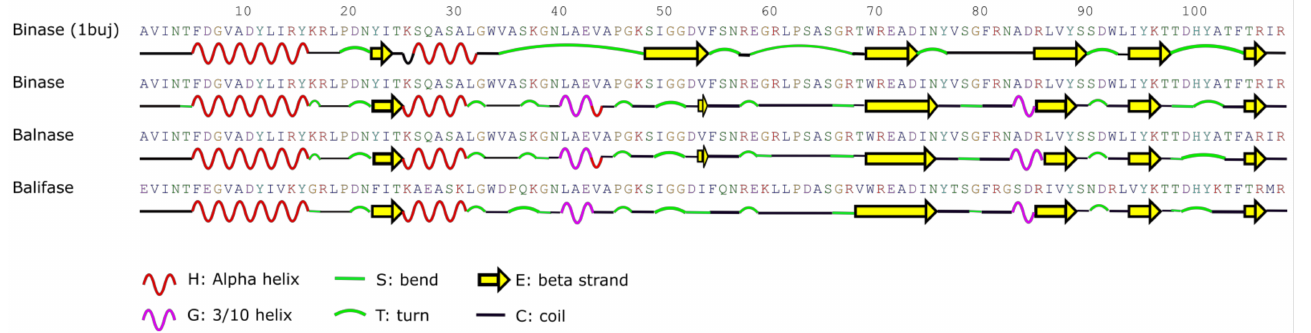
Figure 1. Distribution of structured regions along the RNase chains. Secondary structures of binase, balifase and balnase were predicted based on their amino acid sequences by DeepCNF. The elements of secondary structure of binase in solution (1buj) were extracted from PDB